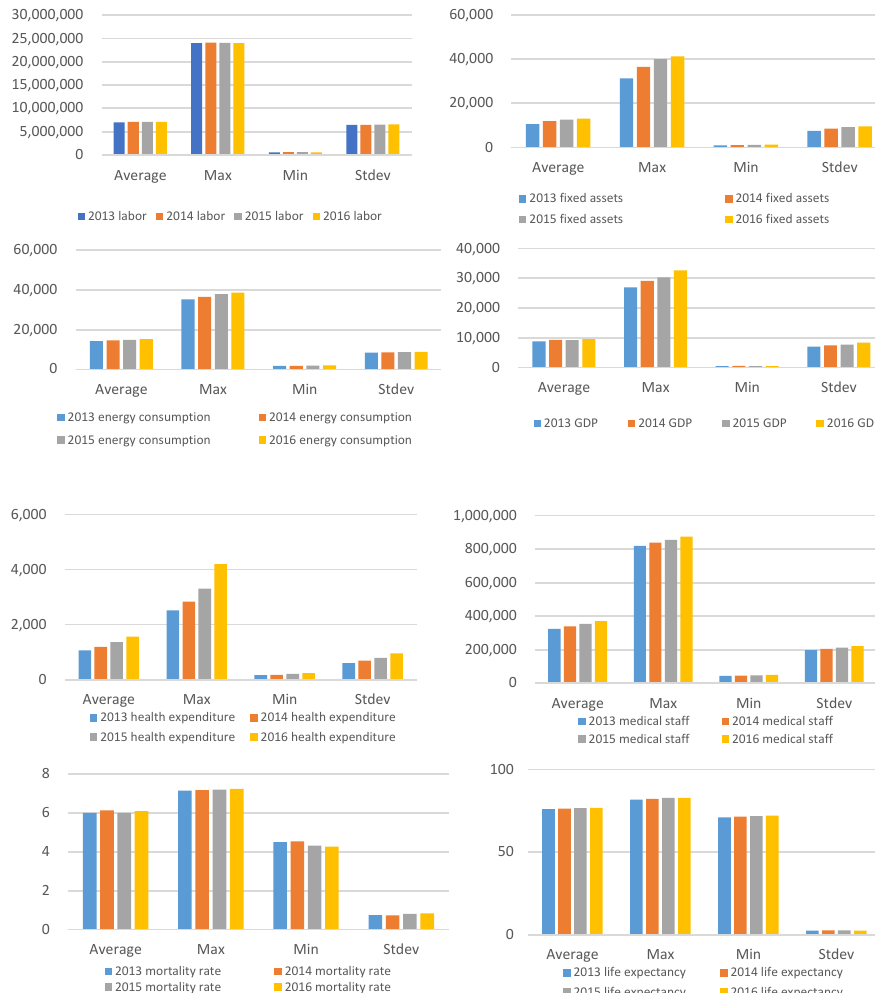
Figure 2. Input-output statistics from 2013 to 2016.